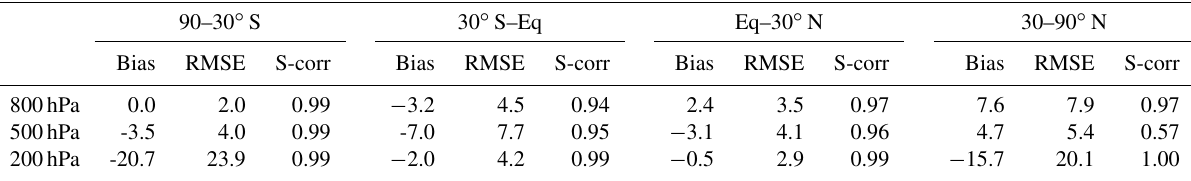
Table 4. ACCMIP model mean minus reanalysis comparisons of the mean ozone concentrations. Units of bias and RMSE are ppb. S-corr is the spatial correlation